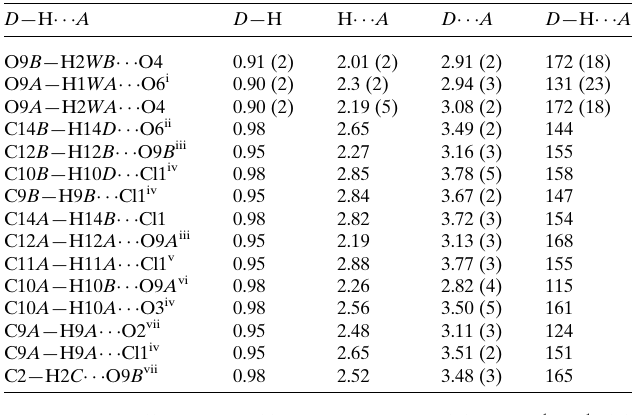
ated water molecules and acetate ions as ligands (O5— H5 B (cid:3) (cid:3) (cid:3) O11, see Table 5). The other water molecule, which is not coordinated to copper(II), also plays an important role in crystal lattice formation – this water molecule connects two